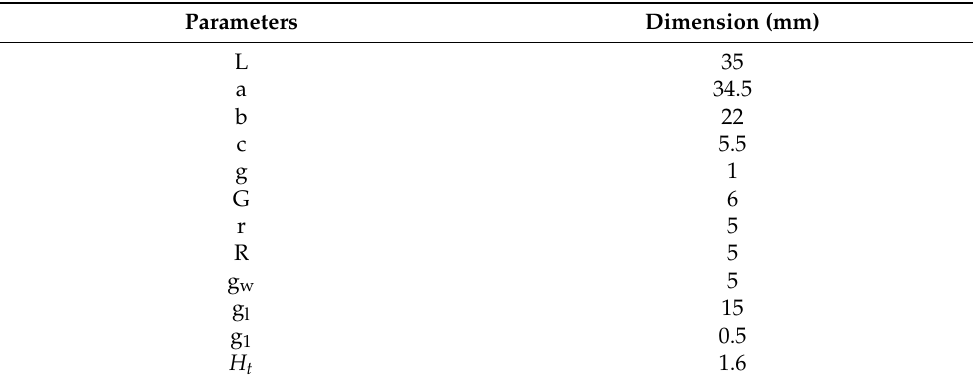
Figure 5. Unit cell Structure, ( a ) Top view, ( b ) Rear view. Table 2. Parameter Specifications of designed Unit Cell.